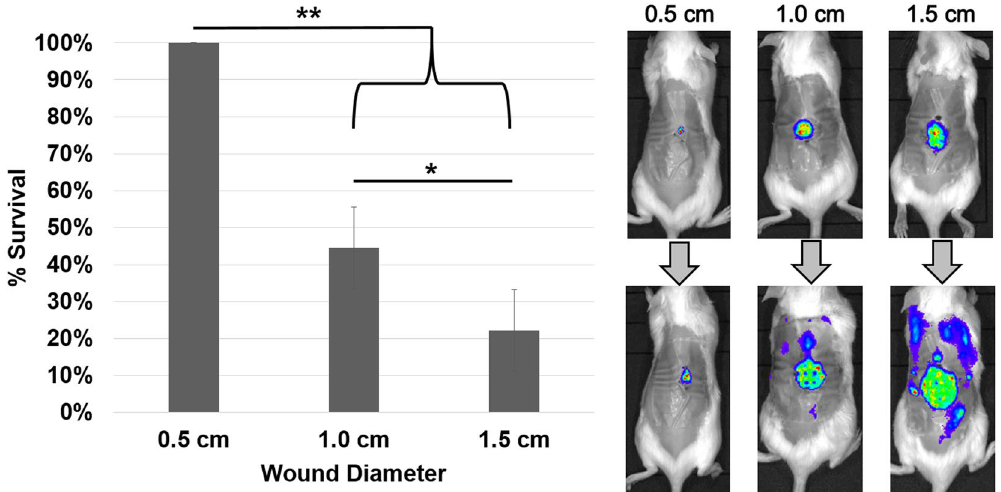
Figure 3. Wound size is positively correlated with dispersal-induced septicemia. Treatment of 48-hour mouse chronic wounds of varying sizes (0.5, 1.0, and 1.5 cm in diameter) with 10% α -amylase and cellulase (1:1; GH) resulted in no mortality in the 0.5 cm group after 36 hours, and significantly increased mortality in the 1.0 cm and 1.5 cm groups, indicating that increased wound size is correlated with septicemia. A representative mouse for each wound size, before and after treatment, is shown on the right, with arrows indicating treatment. Repeated measures ANOVA and the Tukey-Kramer multiple-comparison test were used to test for differences between columns: * p < 0.05, ** p < 0.01. N = 9 for each